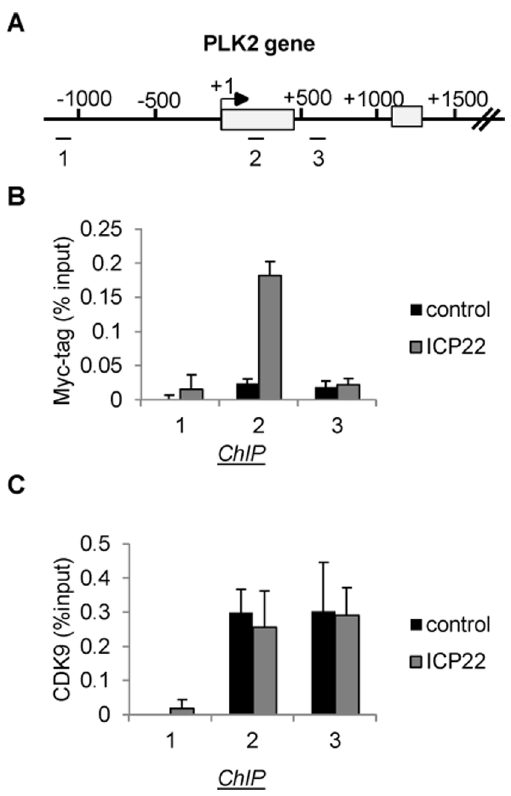
Figure 4. ICP22 is associated with cellular genes but does not affect recruitment of CDK9. ( A ) Diagram of the PLK2 gene, with the position of chromatin immunoprecipitation (ChIP) primer pairs indicat- ed. ( B ), ( C ) ChIP analysis using the antibodies indicated on the left after transfection of vectors expressing the Myc-tagged ICP22 or pcDNA3 (control) as indicated.